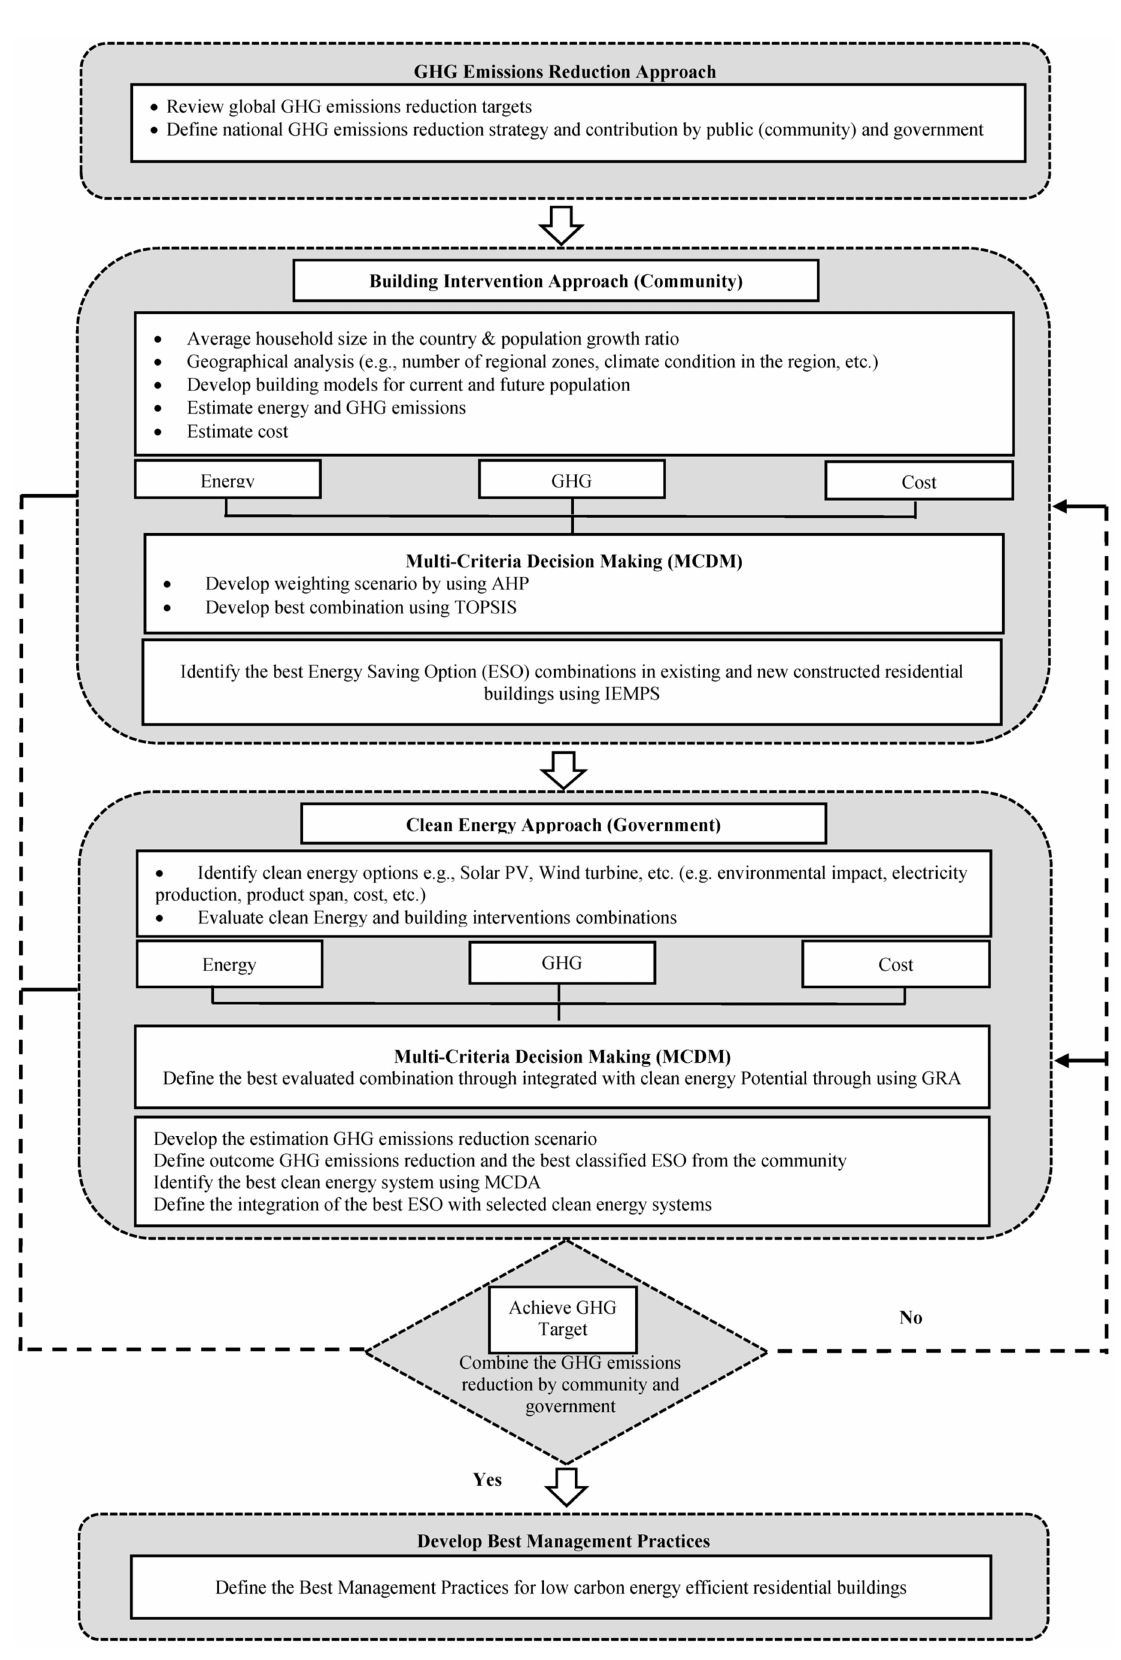
Figure 1. Community–government partnership framework for using low-carbon energy in